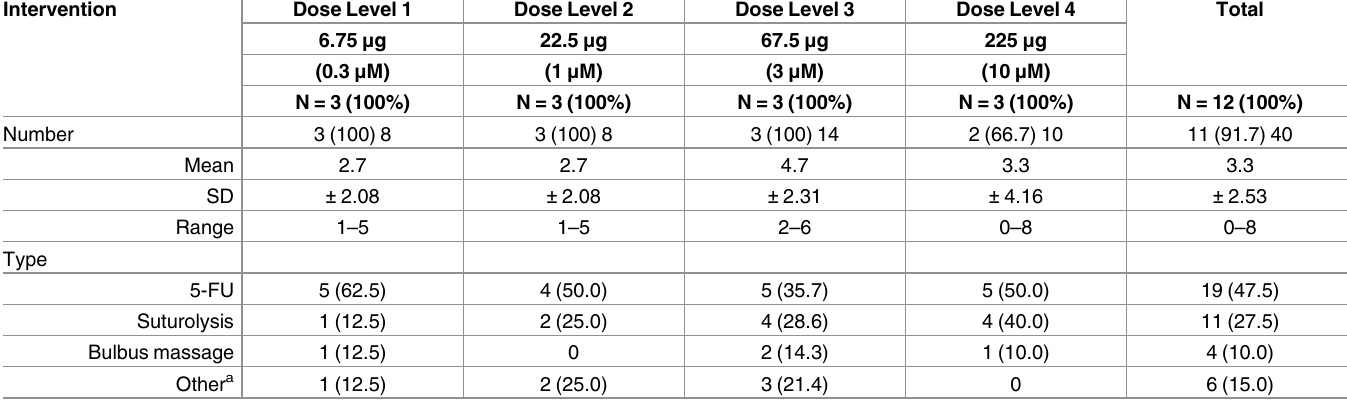
patients undergoing trabeculectomy with MMC. No adverse event observed was linked to ISTH0036 and safety evaluations such as ERG did not indicate any toxicity by the compound. Regarding efficacy, a dose-response trend regarding IOP could be observed for the two highest doses evaluated. Remarkably, none of the six patients treated at these dose levels exceeded an IOP of 10 mmHg in the observation period (12 weeks), maintaining early postoperative IOP Table 4. Postoperative